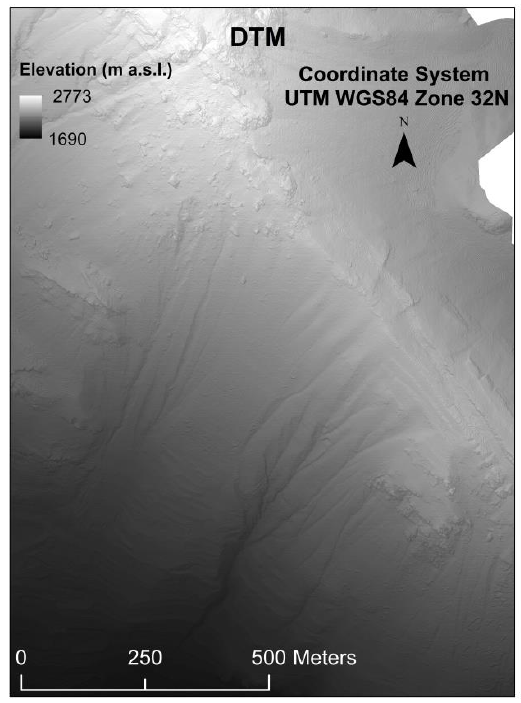
Figure 5. Particular of generated DTM